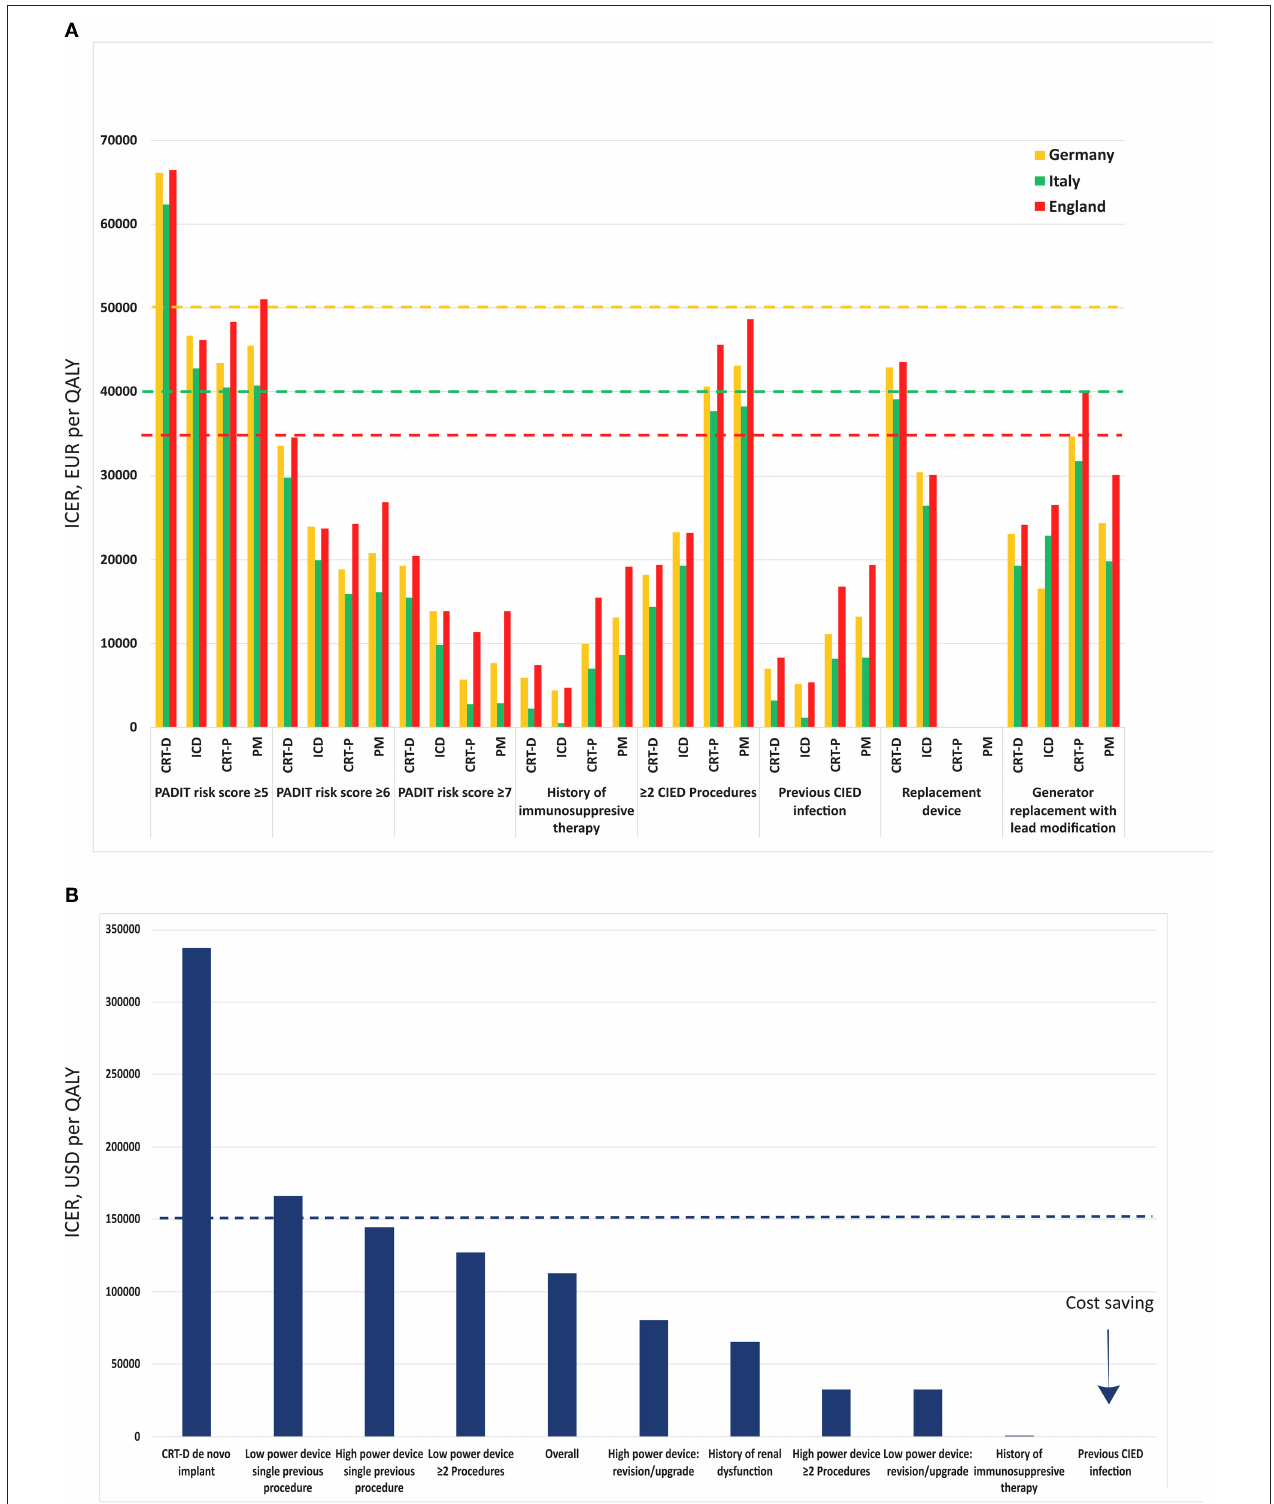
FIGURE 1 | Incremental Cost Effectiveness Ratio (ICER) per Quality Adjusted Life Year (QALY) among different subgroups and based on the population from WRAP-IT trial. Results are shown for Europe (A) as reported by Boriani et al. (54) and in US (B) as reported by Wilkoff et al. (55). The dashed lines represent the willingness to pay threshold for each country. The values for UK have been recalculated in Euro to facilitate comparability. CIED–cardiac implantable electronic device, CRT-D–cardiac resynchronization defibrillator, CRT-P–cardiac resynchronization pacemaker, ICD–implantable cardioverter defibrillator, PM–pacemaker.